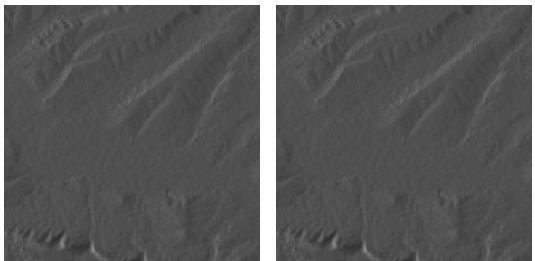
Figure 4. Simulated intensity image (Left: master image, Right: slave image)